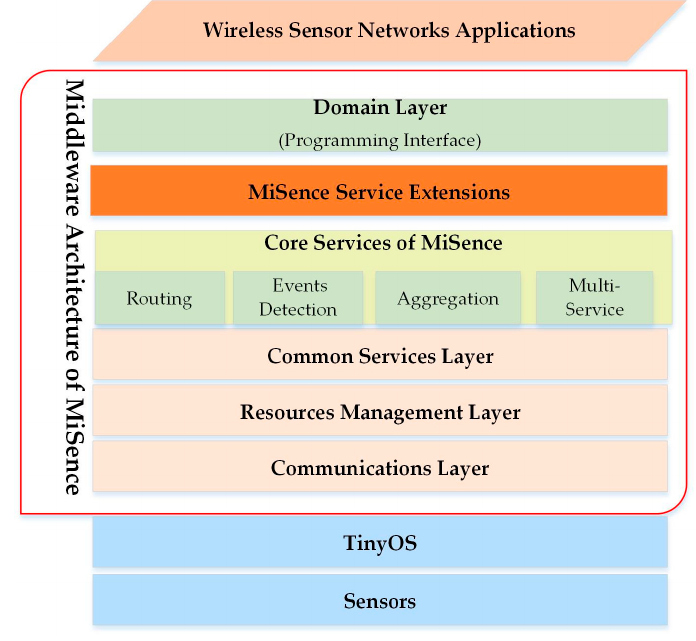
Figure 6. MiSense Architecture [42].